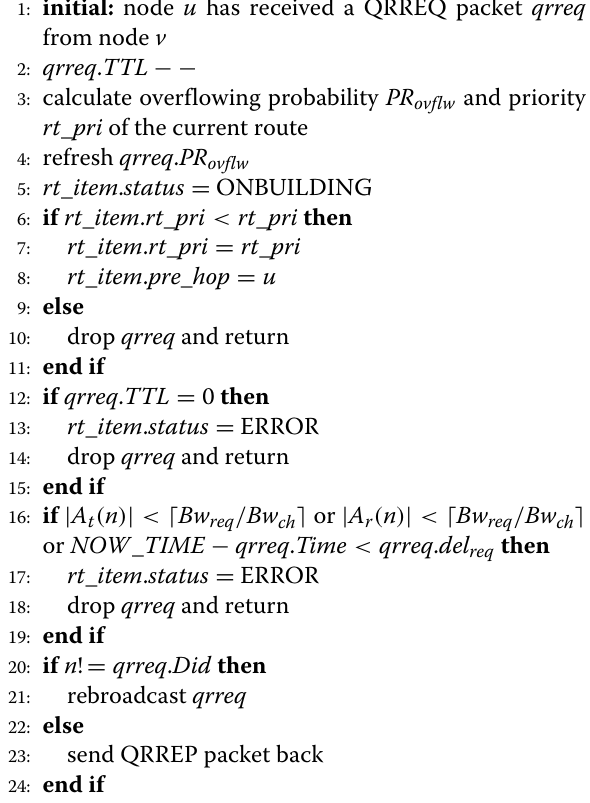
Algorithm 2 Process of Receiving a QRREQ packet